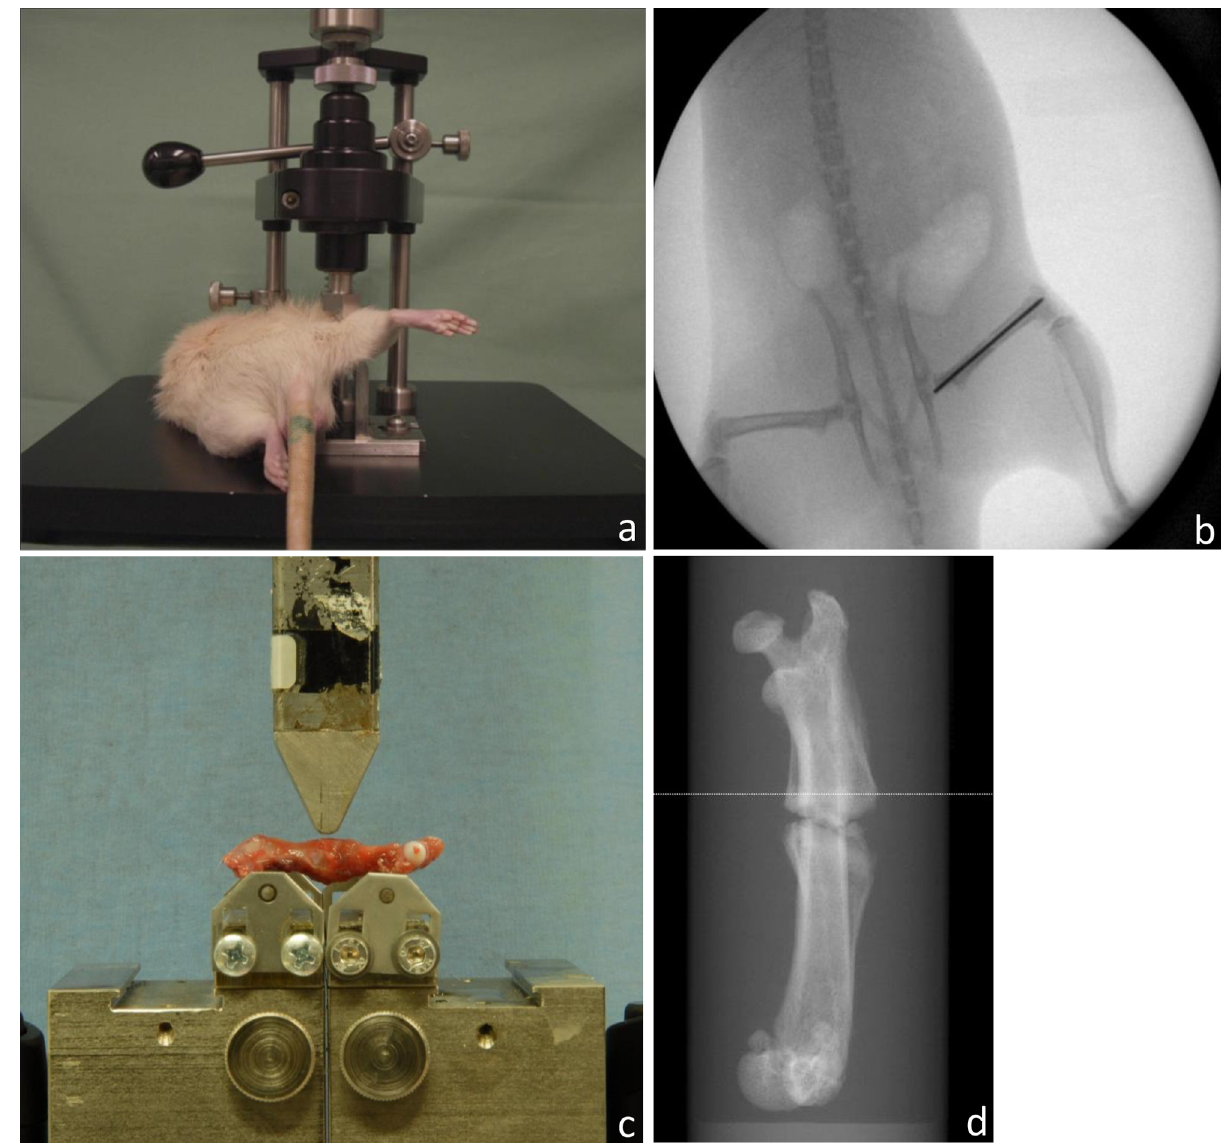
Fig 1. Experimental Setup. (a) Standardized fracture: Anesthetized animal placed on the fracture device. Leg placed across an open platform. (b) Postoperative radiograph, a.p. view after fracture. A transverse fracture with minimal dislocation can be seen at the middle of the femoral shaft. (c) Setting during biomechanical testing of the specimens. The distance between the bars was adapted for each bone. All bones were loaded until failure (V-max) with a persistent test velocity of 5mm/min. Meanwhile a load-displacement diagram was recorded every 0.1 second and thereby failure load was determined. (d) Scout view scan before μ